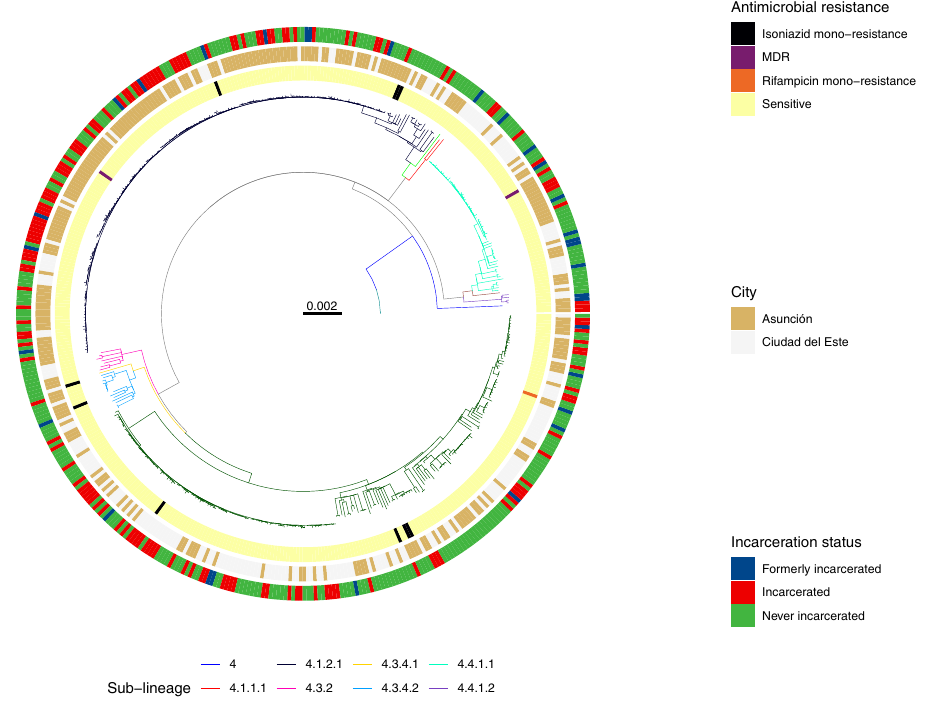
Fig. 2 | M. tuberculosis isolates fromincarceratedand non-incarceratedpeople are closely related across Paraguay. A maximum likelihood phylogeny of 471 tuberculosis isolates from Lineage 4 inferred from a multiple sequence alignment of 9966SNPs and rootedon three sub-lineage 4.8 samples from this study. Branch lengths are in units of substitutions per site. Branches are colored by sub-lineage.